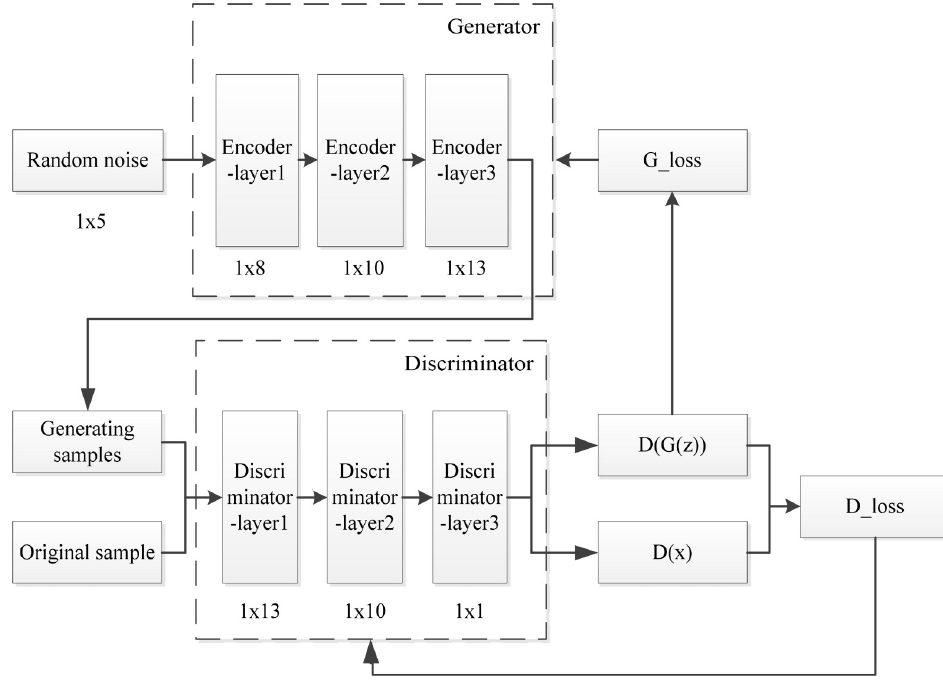
Fig 9. GAN structure diagram for data processing.